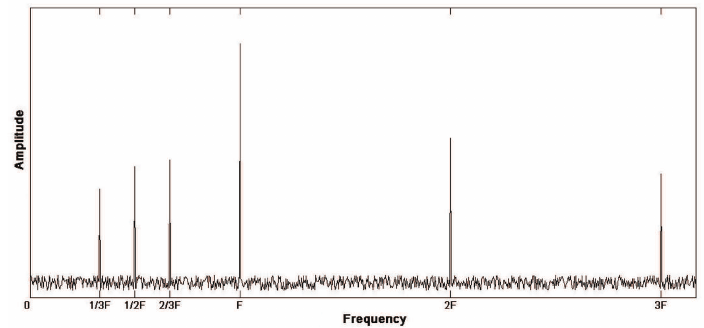
Figure 3. Spectrum diagram of excessive backlash of gear tooth.